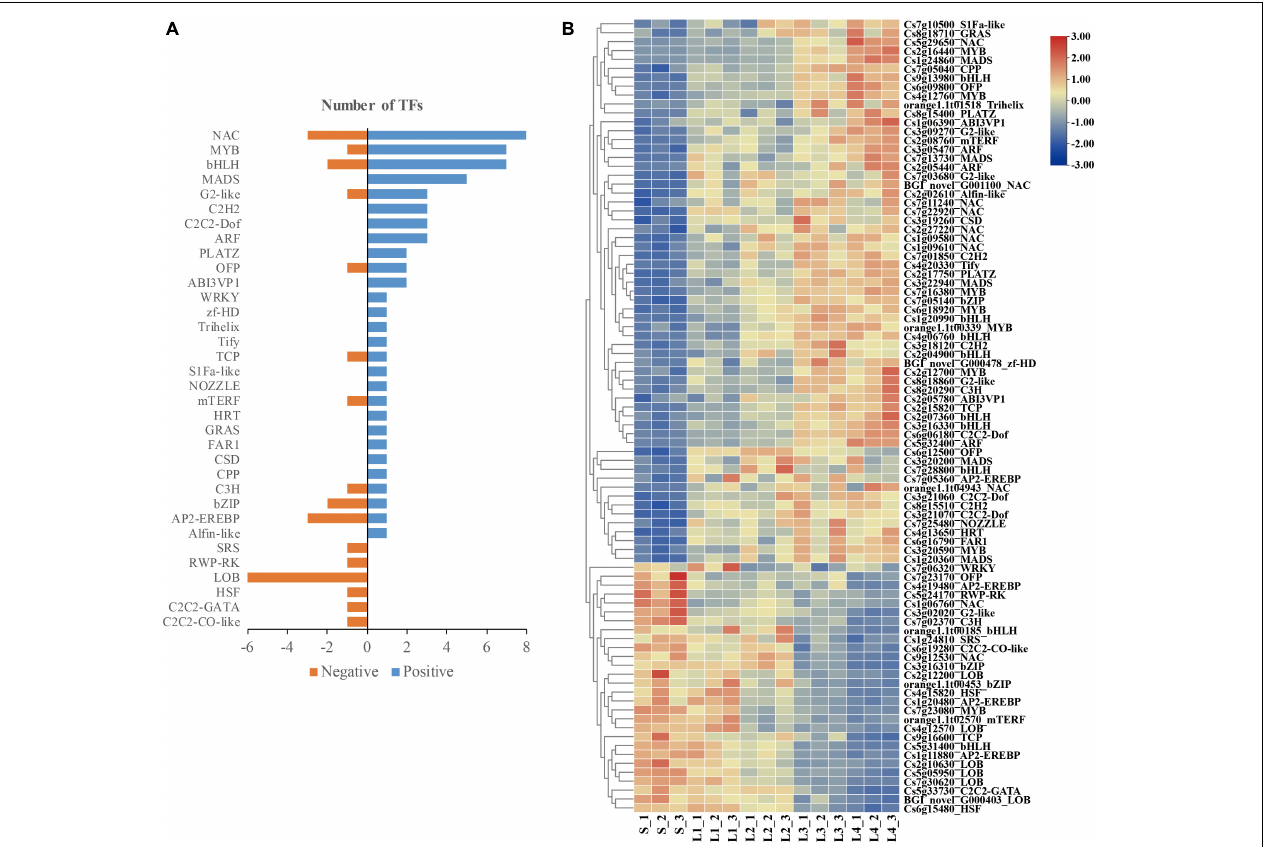
FIGURE 8 | Transcription factors (TFs) correlated to the granulation process. (A) Number of TFs in different families. (B) Heatmap presenting the expression patterns of different TFs in response to granulation